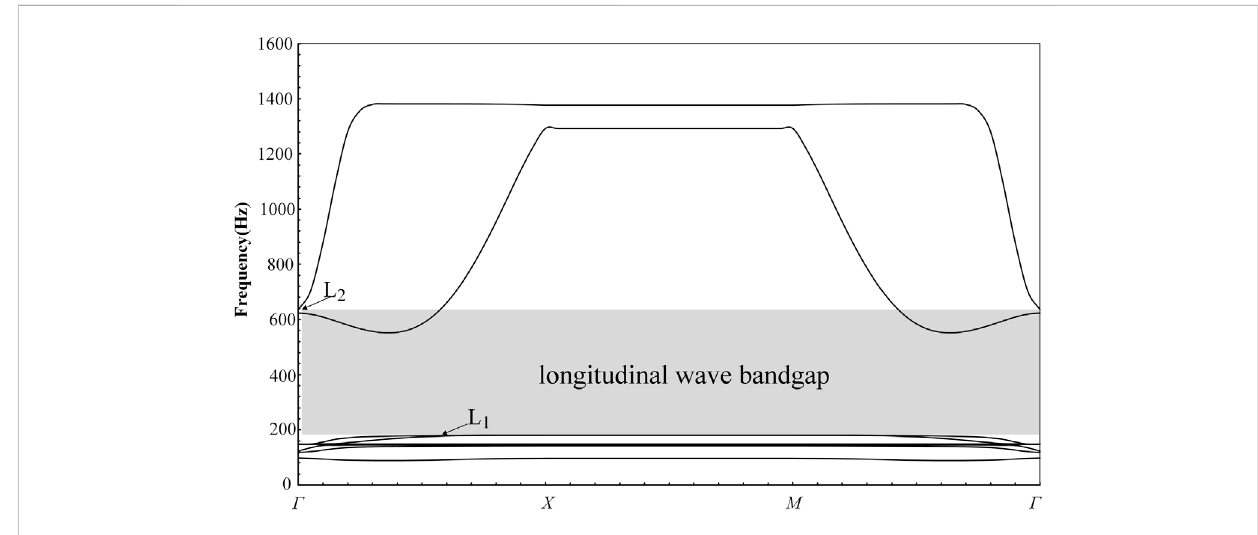
FIGURE 2 Dispersion curves of the unit cell with r 1 = 10